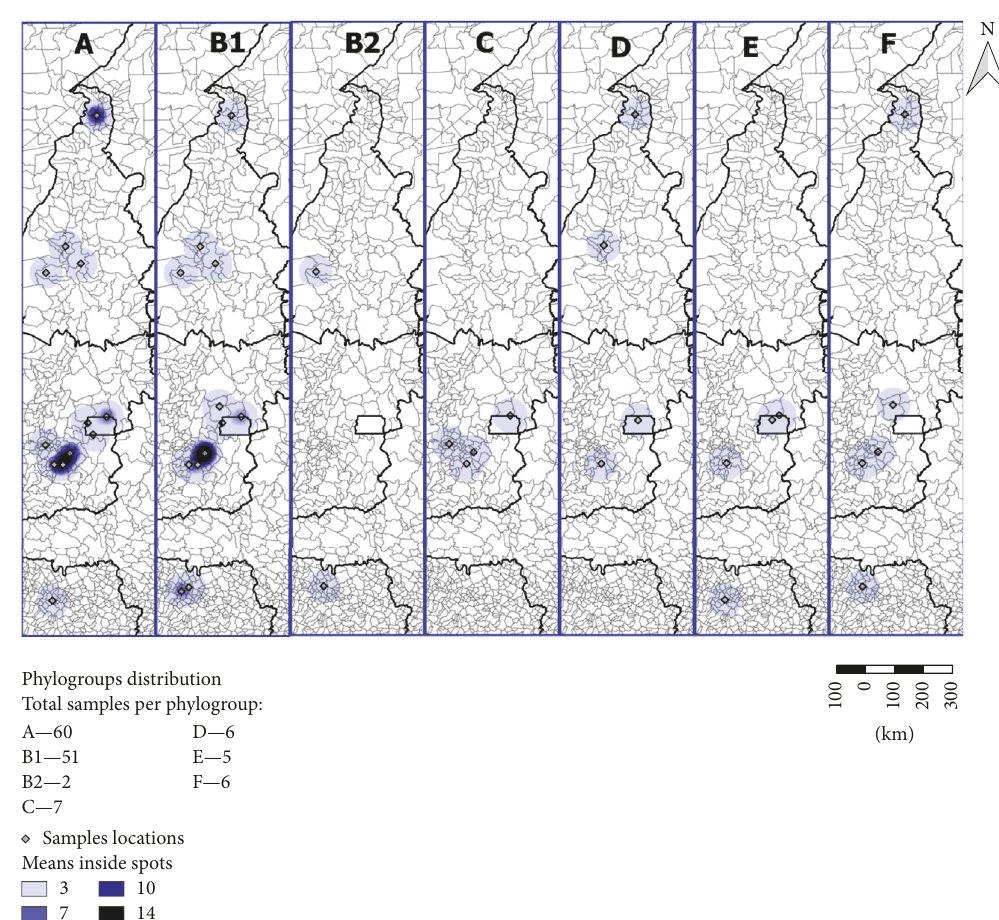
Figure 2: Spatial kernel density estimator of the distribution of the phylogenetic groups of E. coli strains isolated from the respiratory tract, liver, and heart of broilers at a slaughterhouse according to the city of origin of the batch of broilers to be slaughtered.